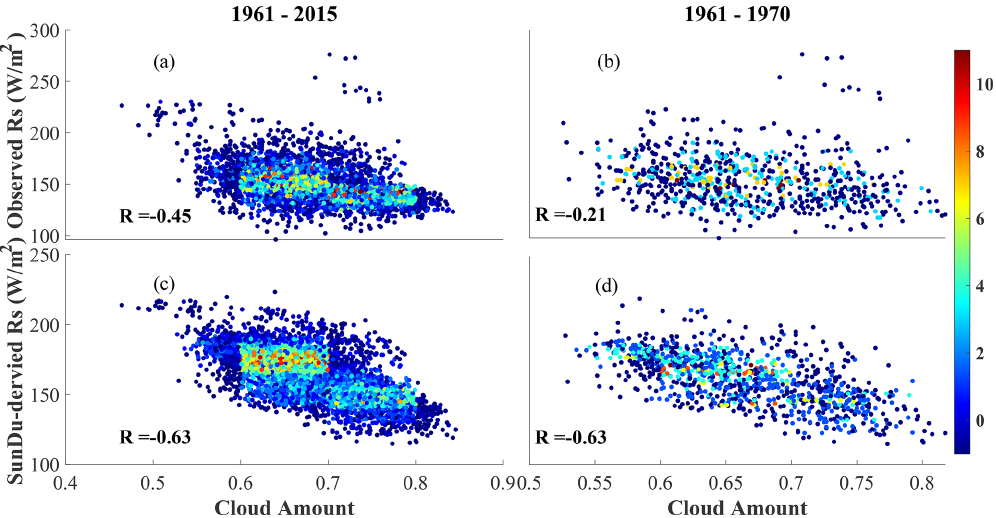
Figure 11. Scatter plot of homogenized monthly surface incident solar radiation ( R s ) (observed and SunDu-derived solar radiation) as a function of ground-based observations of cloud amount over Japan at all stations only when both cloud amount data and observed R s data are available: (a, c) for 1961–2015 and (b, d) for 1961–1970. The smallest correlation coefficient in (b) indicates that the observed R s data are spurious for 1961–1970 and that SunDu-derived R s are more convincing.